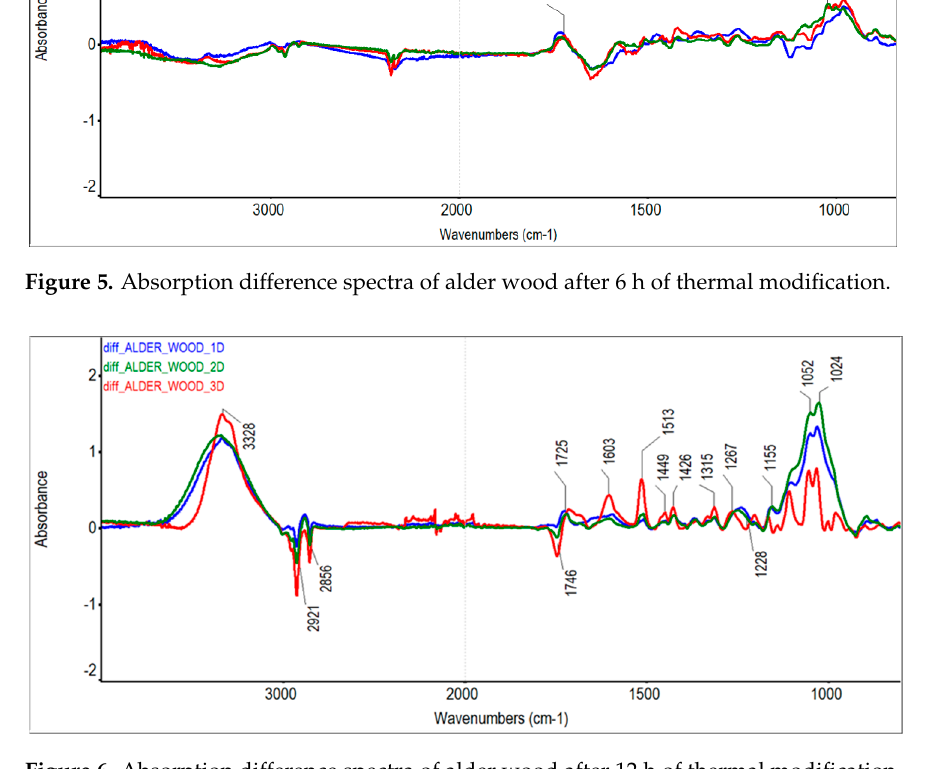
Figure 6. Absorption difference spectra of alder wood after 12 h of thermal modification.